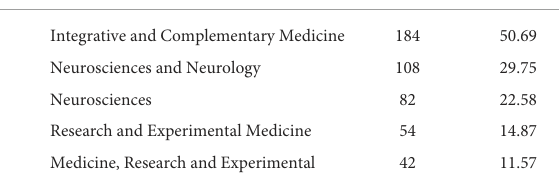
TABLE 3 Top five research areas related to acupuncture treatment of cognitive